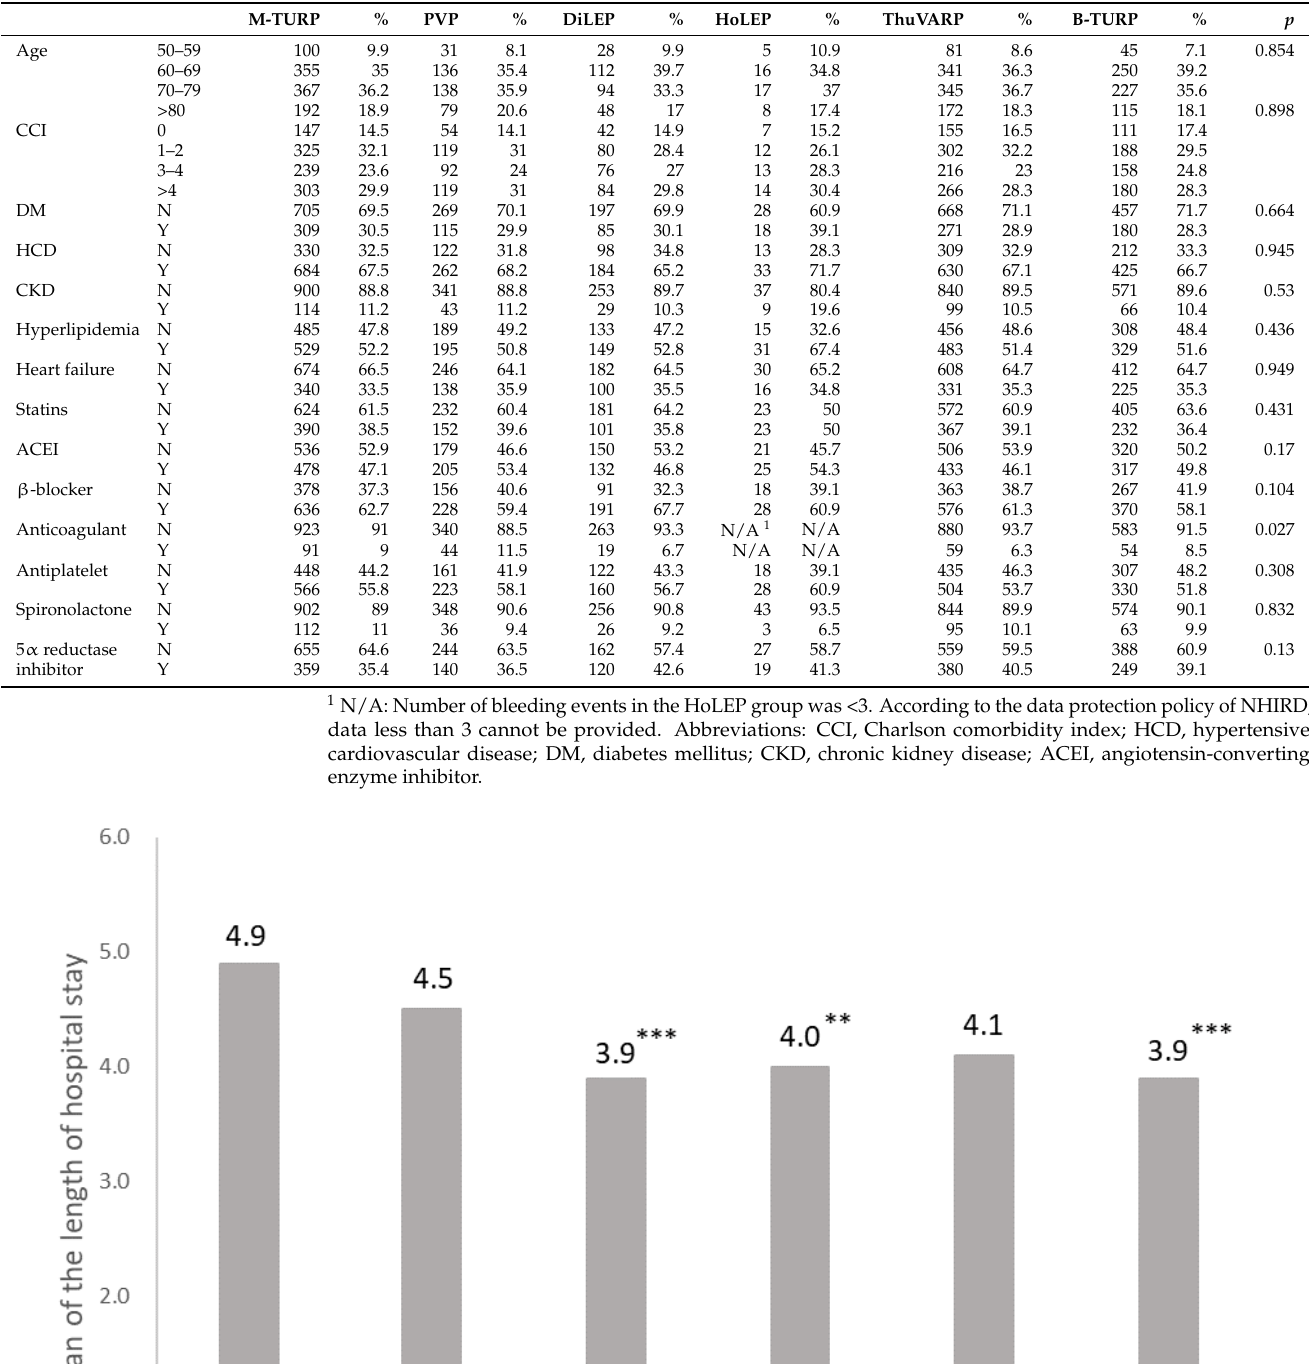
Table 2. Baseline characteristics of patients who underwent different LEPs or TURPs.